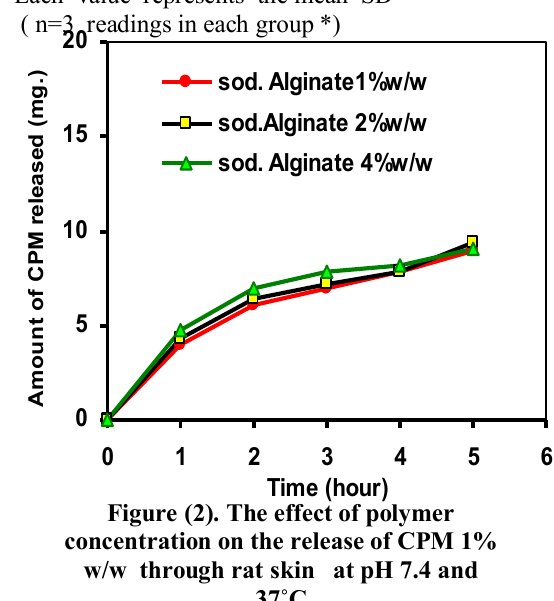
Figure (2). The effect of polymer concentration on the release of CPM 1% w/w through rat skin at pH 7.4 and